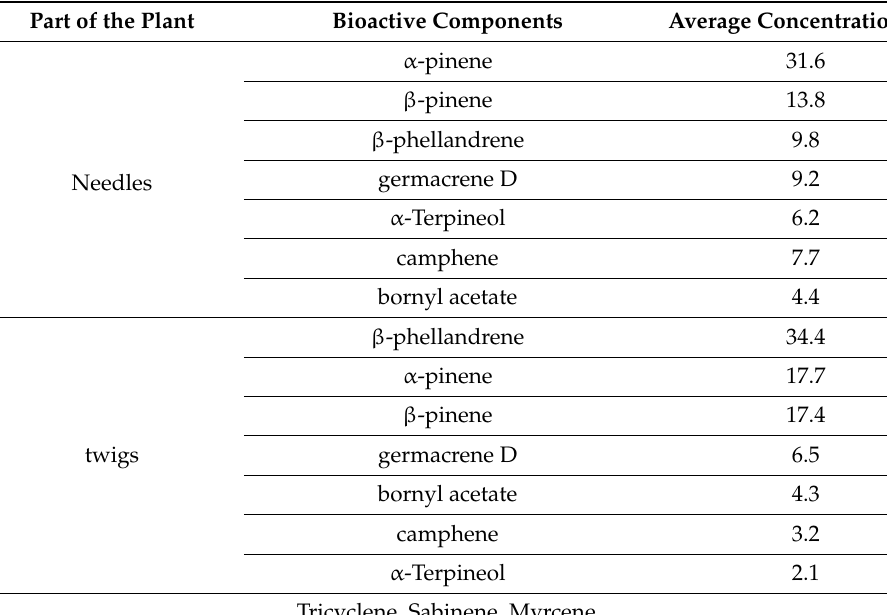
Table 5. The composition of essential oils extracted from pine